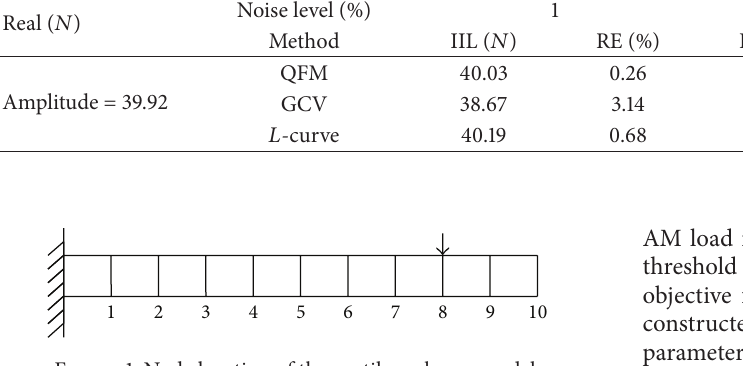
Figure 1: Node location of the cantilever beam